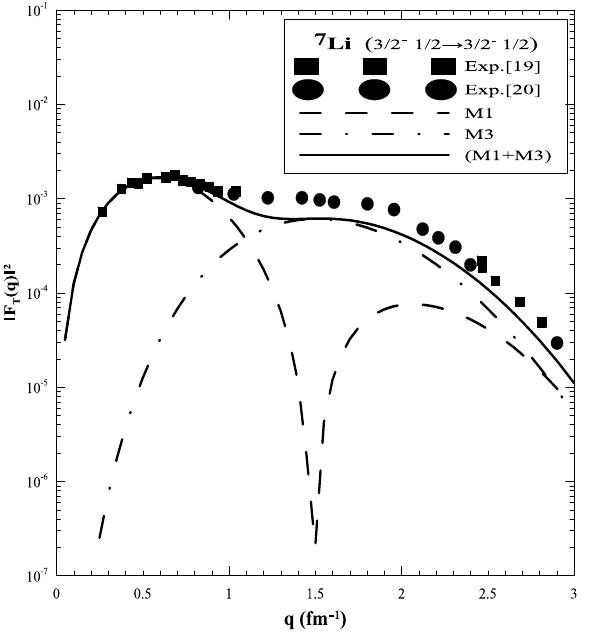
Fig. 2: Comparison between the total form factors of 7 Li nucleus with the size parameter b=1.74fm (solid curve). and b=1.65fm (dashed